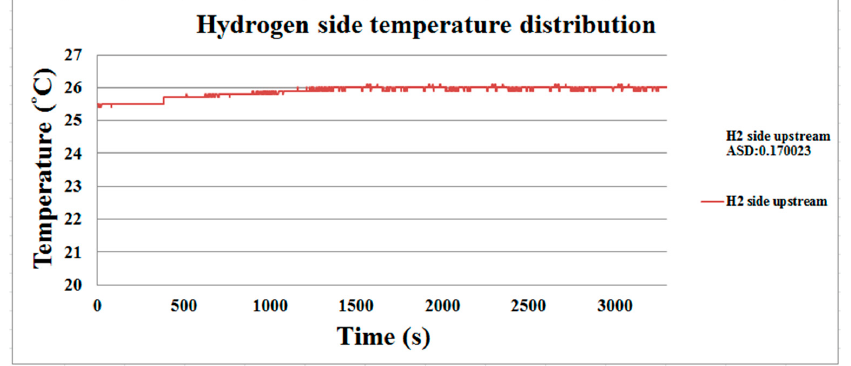
Figure 15. The hydrogen side’s temperature distribution during the proton battery discharge.